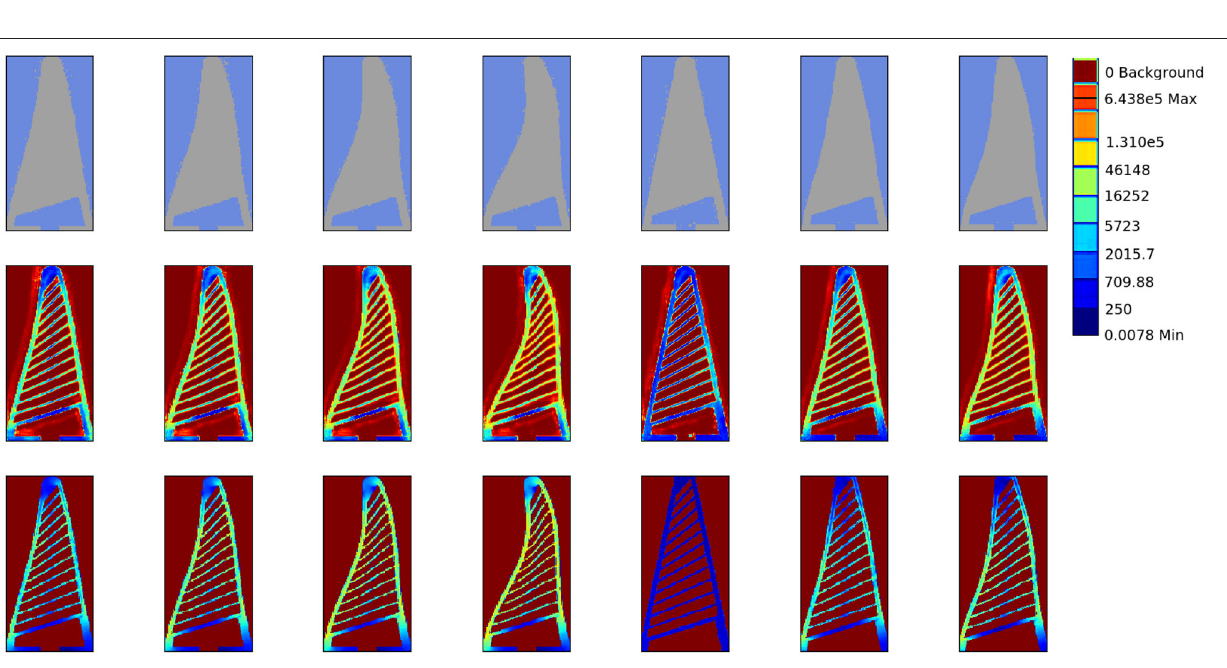
FIGURE 9 | Stress profiling for soft objects. (Top) The input object deformation image to the network, (Middle) The stress map predicted by our network. (Bottom) The ground truth stress map obtained by